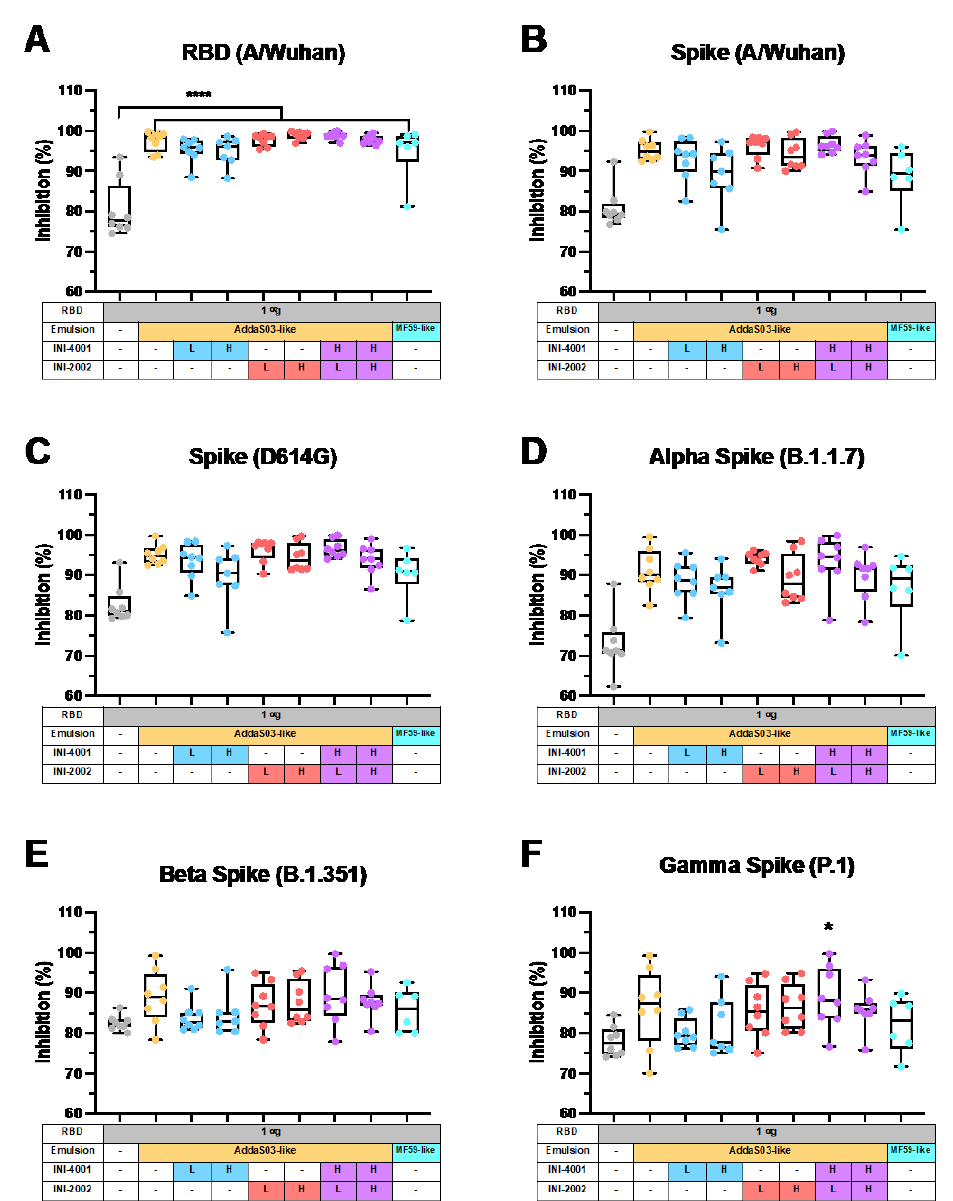
Figure 6. AddaS03-like emulsions, with or without toll-like receptor (TLR) agonists, result in neutralization of SARS-CoV-2 variants. A surrogate virus neutralization test (sVNT) was used to test the neutralization potential of serum taken fourteen days after the booster immunization. The percent reduction in the binding of recombinant ACE2 to the indicated SARS-CoV-2 protein is given for ( A ) RBD (A/Wuhan), ( B ) spike (A/Wuhan), ( C ) spike (D614G mutation), and spike from the variants of concern: ( D ) Alpha (B.1.1.7), ( E ) Beta (B.1.351), and ( F ) Gamma (P.1). Results are presented as box-and whisker plots representing the median and quartiles (box) and range (whiskers) overlaid with data from individual animals. A one-way ANOVA with a post hoc Tukey’s test for multiple comparisons demonstrated significant differences between group means (* p < 0.05 and **** p < 0.0001) when compared to unadjuvanted RBD ( n = 6–8).